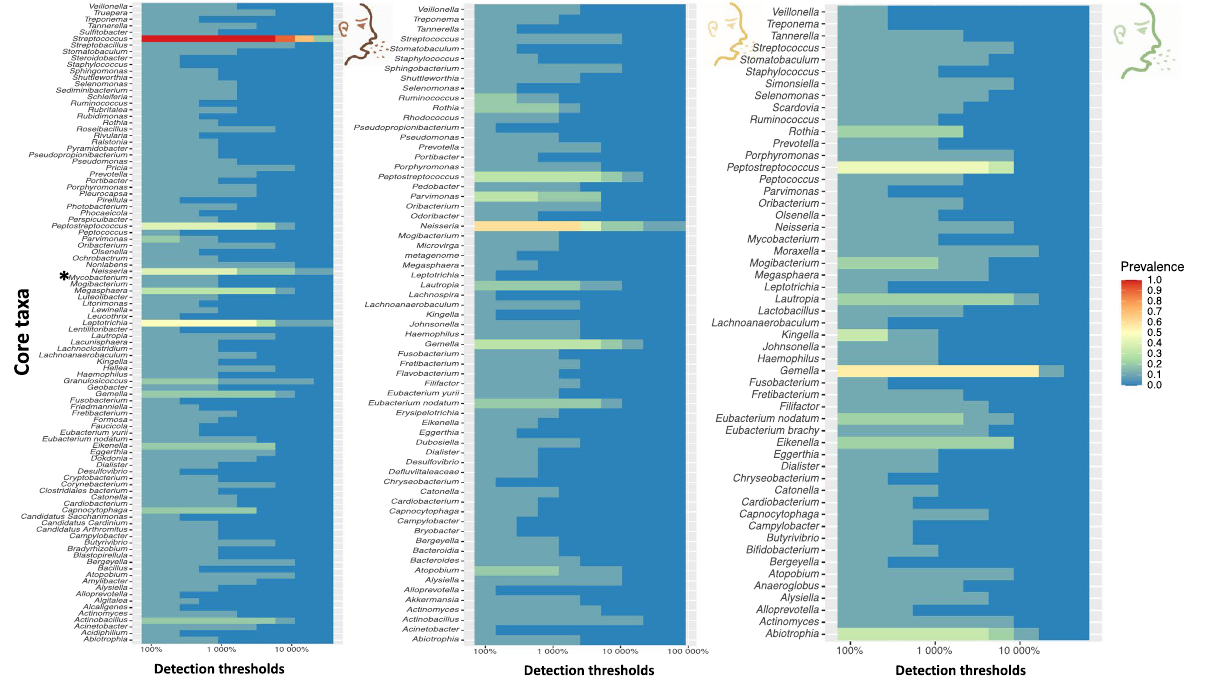
Figure 4. Characterizing the core microbiota during anti-TB treatment. The three panels depict composition of the core genera during treatment as defined by QIIME-2 microbiome package. Note that the genus Mycobacterium is a member of the core before initiating treatment but not during/after treatment. This analysis is based dataset C of Fig.